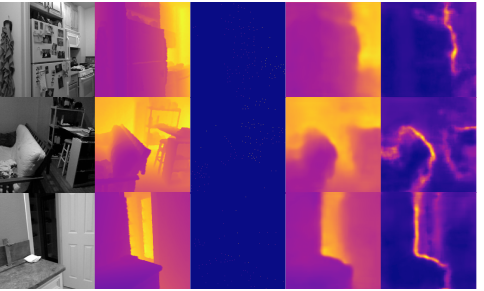
Figure 8. Visualization of dense depth and depth uncertainty prediction on NYU Depth V2 dataset in Gray + Sparse Depth modality. From left to right column: input gray images, dense depth ground truth, sampled sparse FAST corners, and predictions of dense depth and depth uncertainty